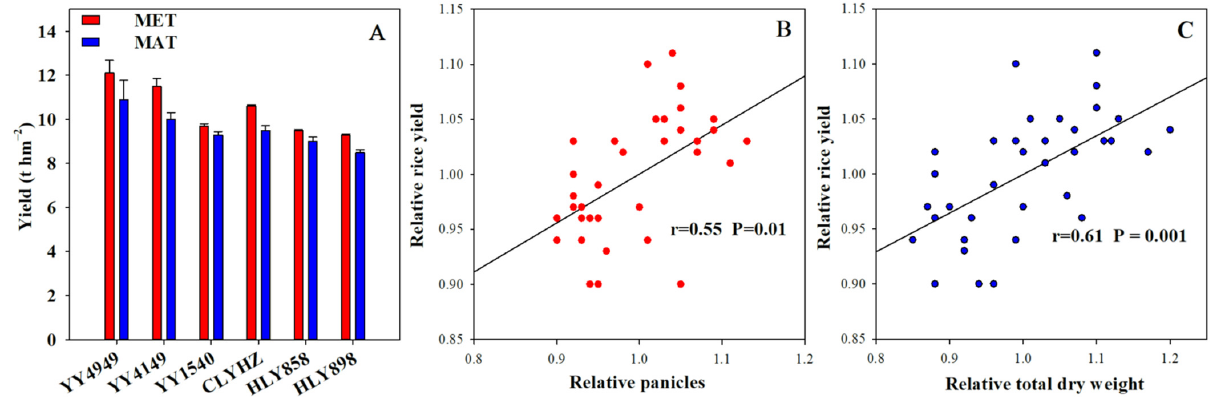
Figure 3. The rice yield in different establishment methods ( A ), and the relationship of relative rice yield with relative panicles ( B ) and relative total dry weight (aboveground biomass) ( C ) at maturity. Data were pooled from examinations conducted in Zaoyang (2016) and Hefei (2017). MET and MAT represent mechanical transplanted method and manual transplanted method, respectively. YY4949, YY4149, YY1540, ClYHZ, HLY858, and HLY898 represented Yongyou 4949 (YY4949), Yongyou 4149, Yongyou 1540, C liangyouhuazhan, Hui liangyou 858 and Hui liangyou 898, respectively. Table 3. Analysis of variance (ANOVA) for yield and yield-related traits . Treatment